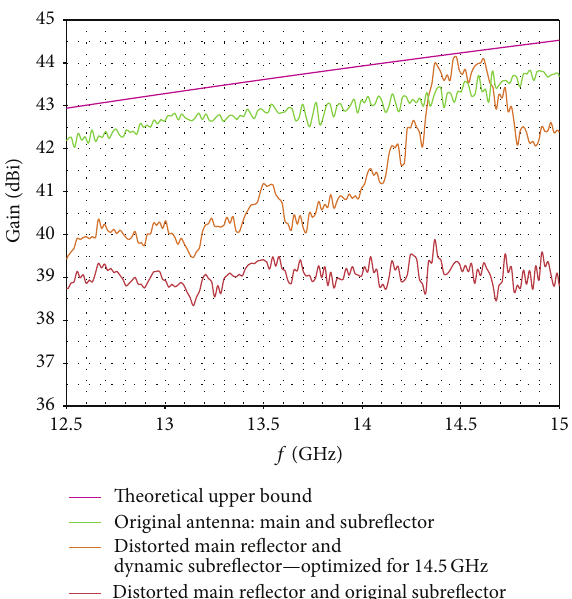
Figure 10: The changes in the subreflector’s surface, presented as a topographic map. The lines are in 0.033 cm scale and represent the changes in height from the original (fixed)